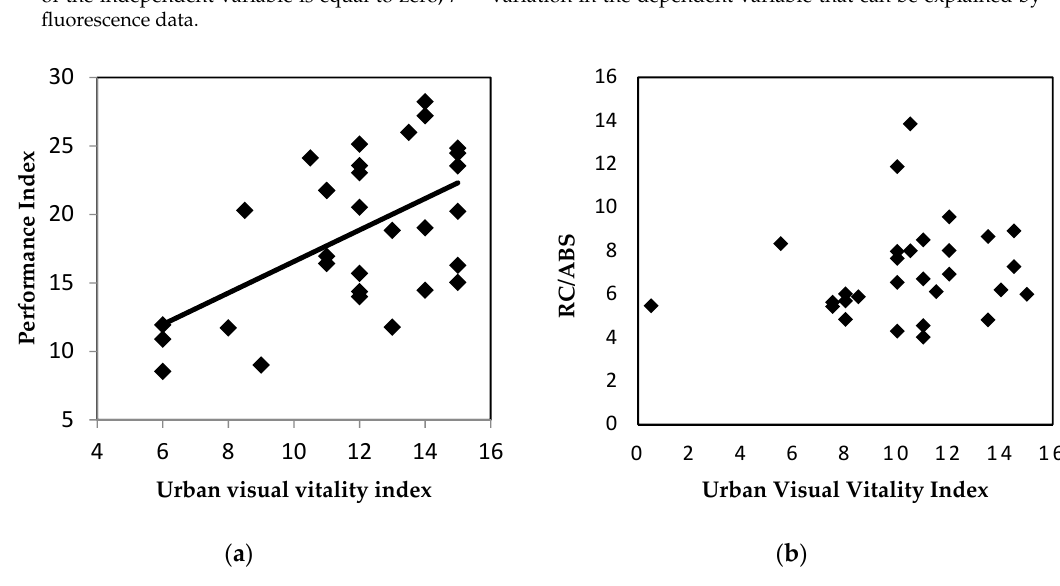
Figure 3 . ( a ) Summer urban tree visual vitality index versus summer bark PI in Ulmus parvifolia . Trend line = linear regression, p = 0.001, r 2 = 0.314, n = 31. ( b ) Summer urban tree visual vitality index versus summer bark RC/ABS in Ficus macrophylla . p = 0.386, r 2 = 0.028, n = 29.